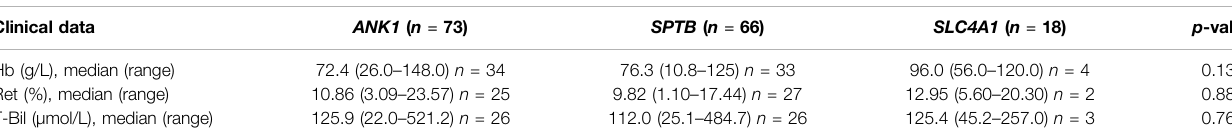
TABLE 3 | Comparison of clinical features of HS patients with SPTB , ANK1 and SLC4A1 mutations. Clinical data